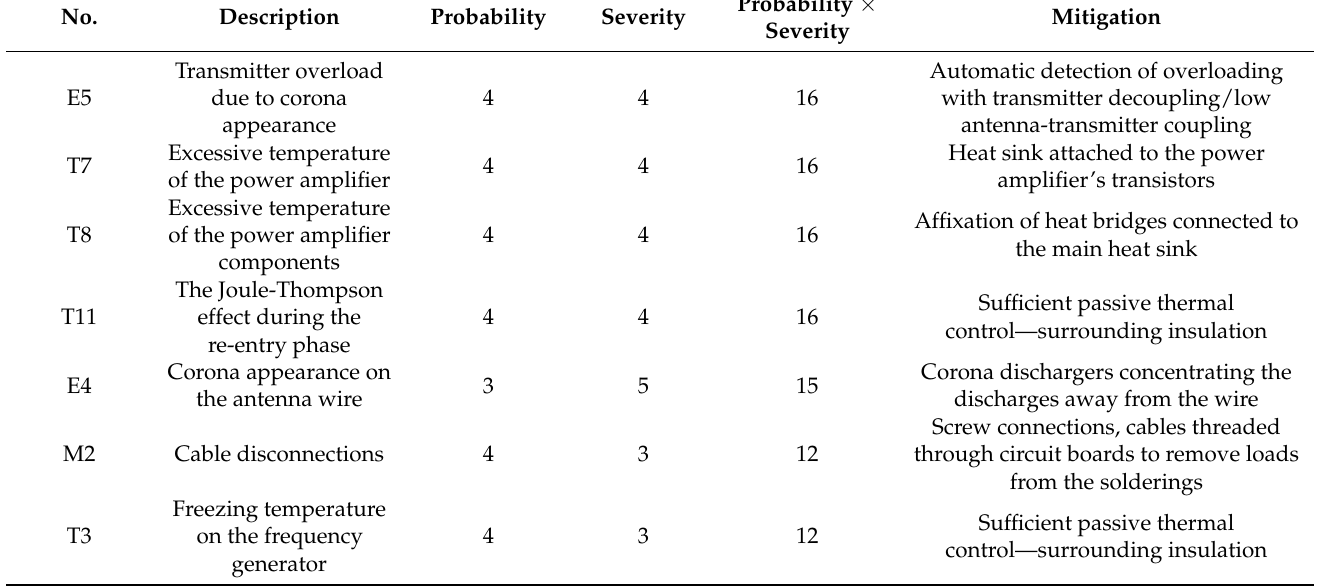
Table 6. Highest-grade risks for a stratospheric fully airborne VLF light balloon